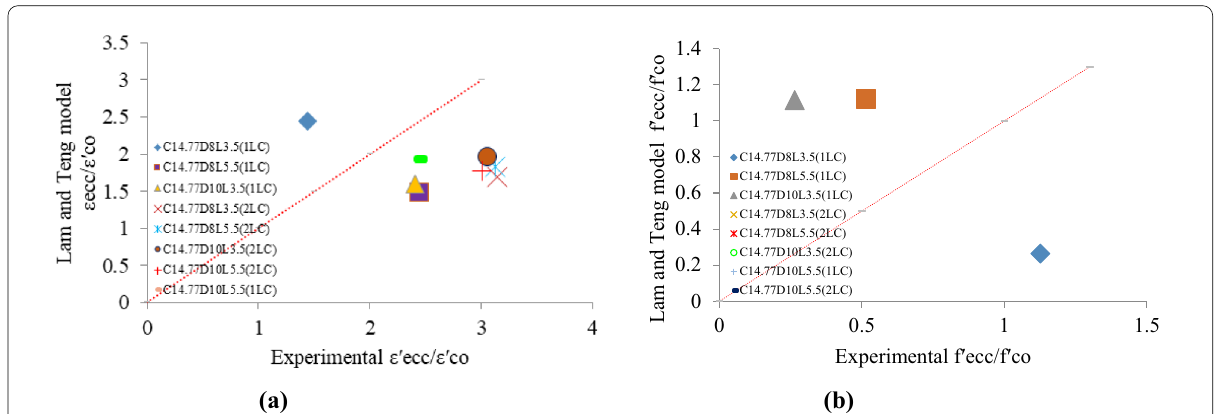
Fig. 14 Comparison between the model proposed by Lam and Teng (Pham et al., 2015) and experimental results: a ultimate axial strain, and b compressive strength.